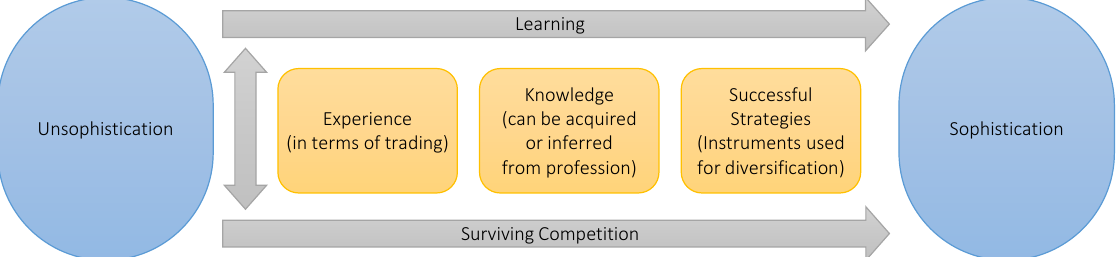
Figure 1. Authors’ conceptualization of Investor Sophistication